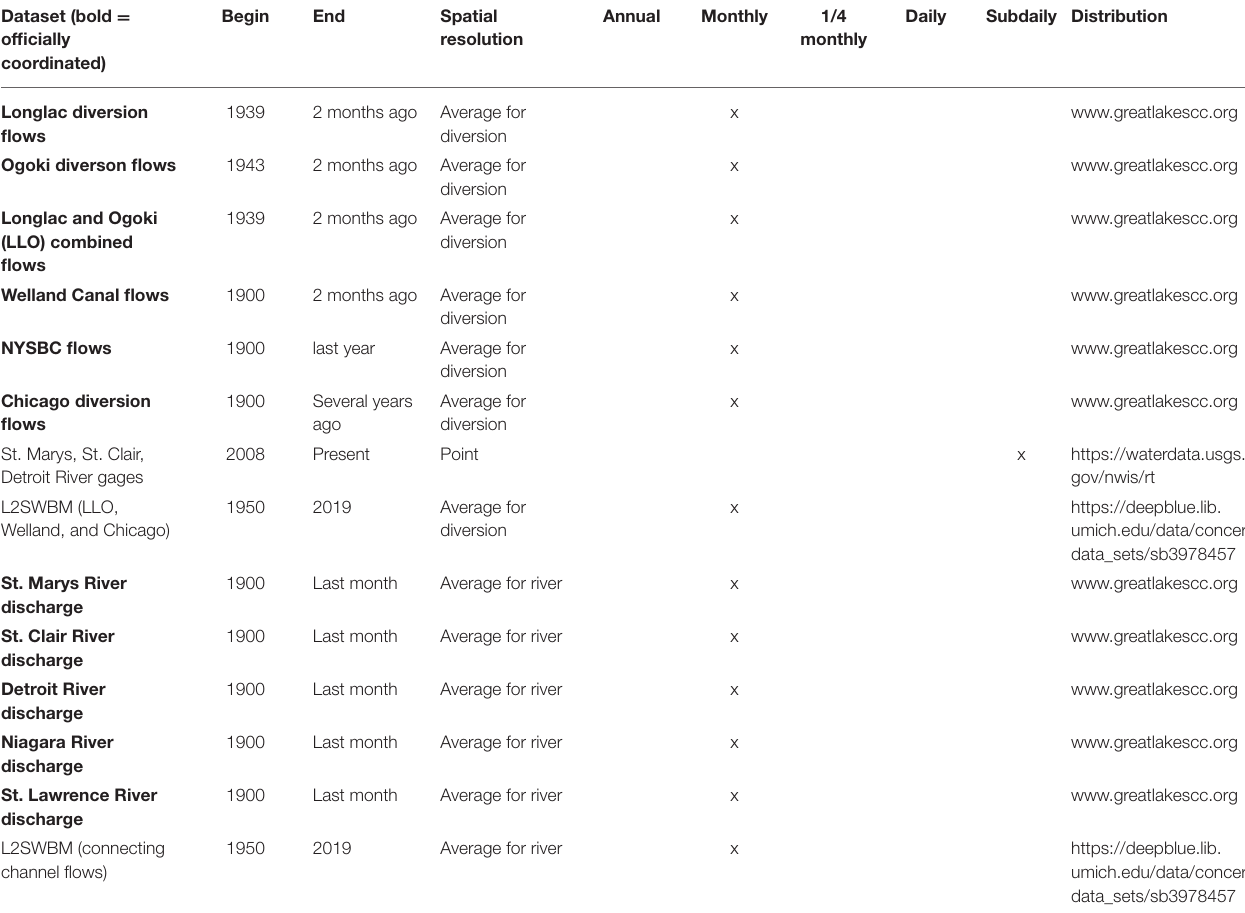
TABLE 2 | Connecting channel and diversion flow products. Dataset (bold = officially coordinated)